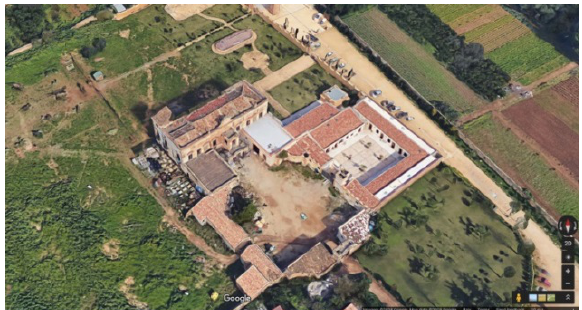
Figure 1. View of Villa Lampedusa ai Colli (from Google Maps©).